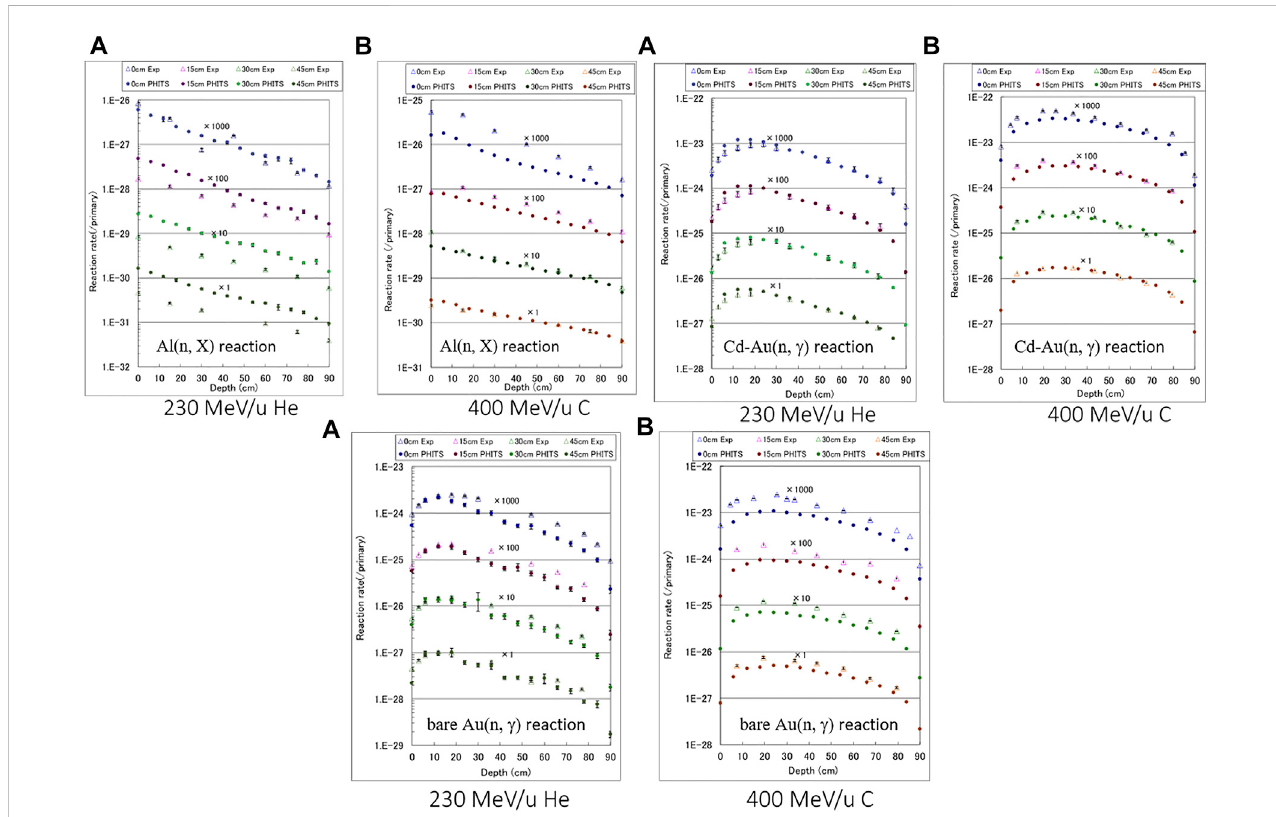
FIGURE 10 Reaction rate distributions of 27 Al (x, X) 24 Na, 197 Au (n, γ ) 198 Au, and 197 Au (n, γ ) 198 Au reactions for (A) 230 MeV/u He reaction and (B) 400 MeV/u C reaction (Ogawa et al., 2011). The experimental errors include one standard deviation based on an uncertainty analysis.